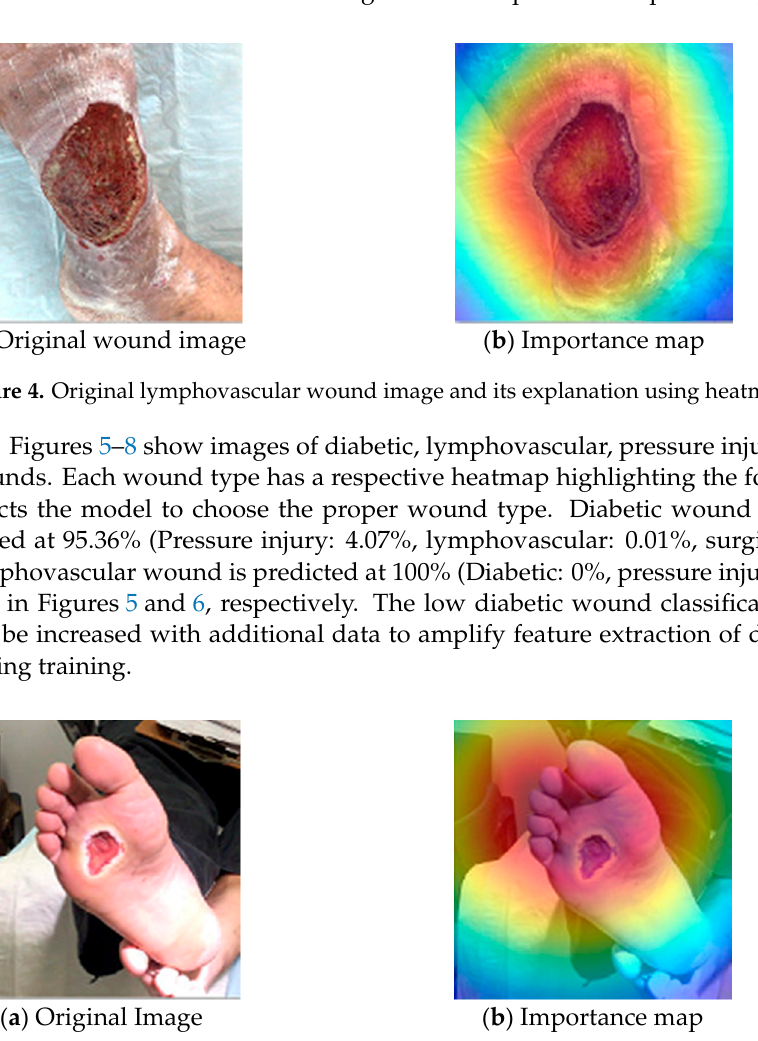
( b ) Importance map Figure 6. The probabilities of wound types: Lymphovascular: 100%, diabetic: 0%, pressure Injury: 0%, surgical: 0% (Lymphovascular). ( a ) Original Image ( b ) Importance map Figure 7. The probabilities of wound types: Pressure Injury: 100%, lymphovascular: 0%, surgical: 0%, diabetic: 0% (Pressure Injury).